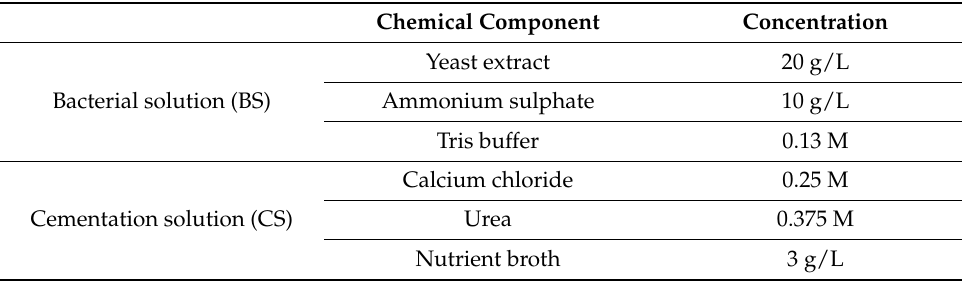
Table 1. The characteristics of bacterial and cementation solution